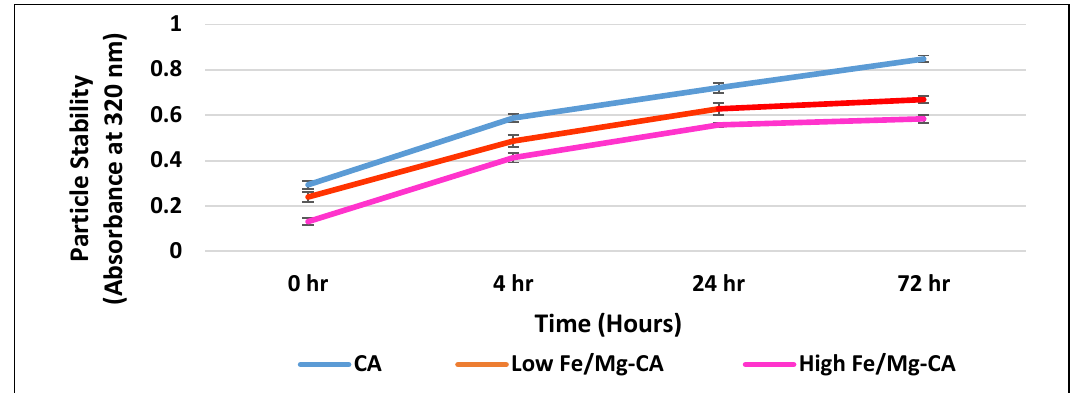
Figure 4. Stability analysis of CA, low Fe/Mg-CA and high Fe/Mg-CA NPs based on turbidity measurement at 320 nm over a period of 72 h. The temperature was maintained at 37 °C throughout the experiment.